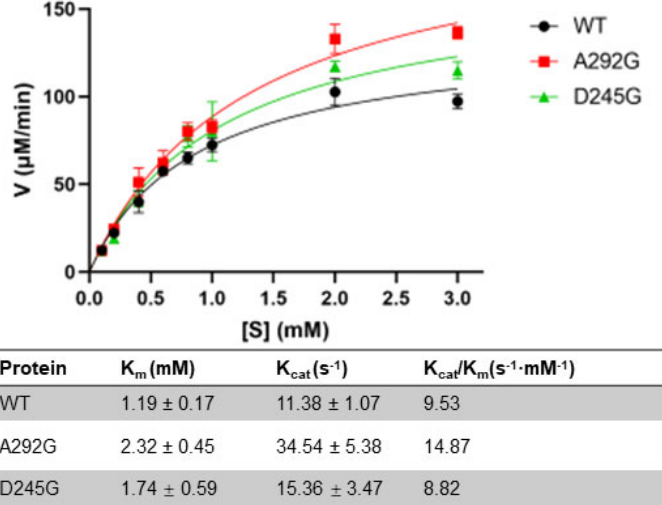
Figure 4. Enzymatic reaction kinetics. The kinetics of hydrolytic reactions were measured for the WT, D245G, and A292G using 4-nitrophenyl caprylate as the substrate. The table below indicates the kinetic parameters of the reactions. Each point represents the average of three independent experiments, with the error bar indicating the standard error of these three experiments.